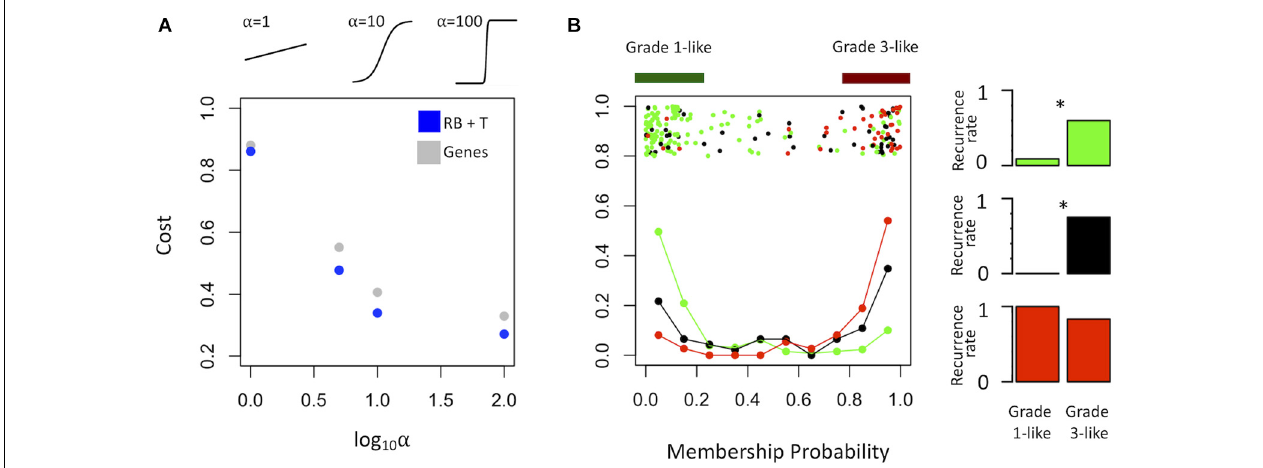
FIGURE 2 | Optimized soft clustering reveals two subgroups of grade 2 meningiomas. (A) Cost of multiple input configurations: “royal blue” (RB) and “tan” (T) modules in blue and optimized differentially expressed genes in gray. Top inset depicts shape of sigmoid function with varied alphas. (B) Summary graph of fuzzy C-means clustering best performing inputs (RB + T). The x -axis represents the probability of being in the grade-3 enriched cluster and y -axis represents the proportion of patients in each bin of 10%. Line graph component represents normalized frequency distribution of each histological grade (green = grade 1, black = grade 2, red = grade 3). Top jitter plot represents individual patients. Dark green and red bars above represent the 20 and 80% thresholding into grade 1-like and grade 3-like subgroups of grade 2 meningiomas. Recurrence rates are plotted on the right by grade (green, black, red) and subgroup (“grade 1-like” and “grade 3-like”). *Chi-square p < 0.05.